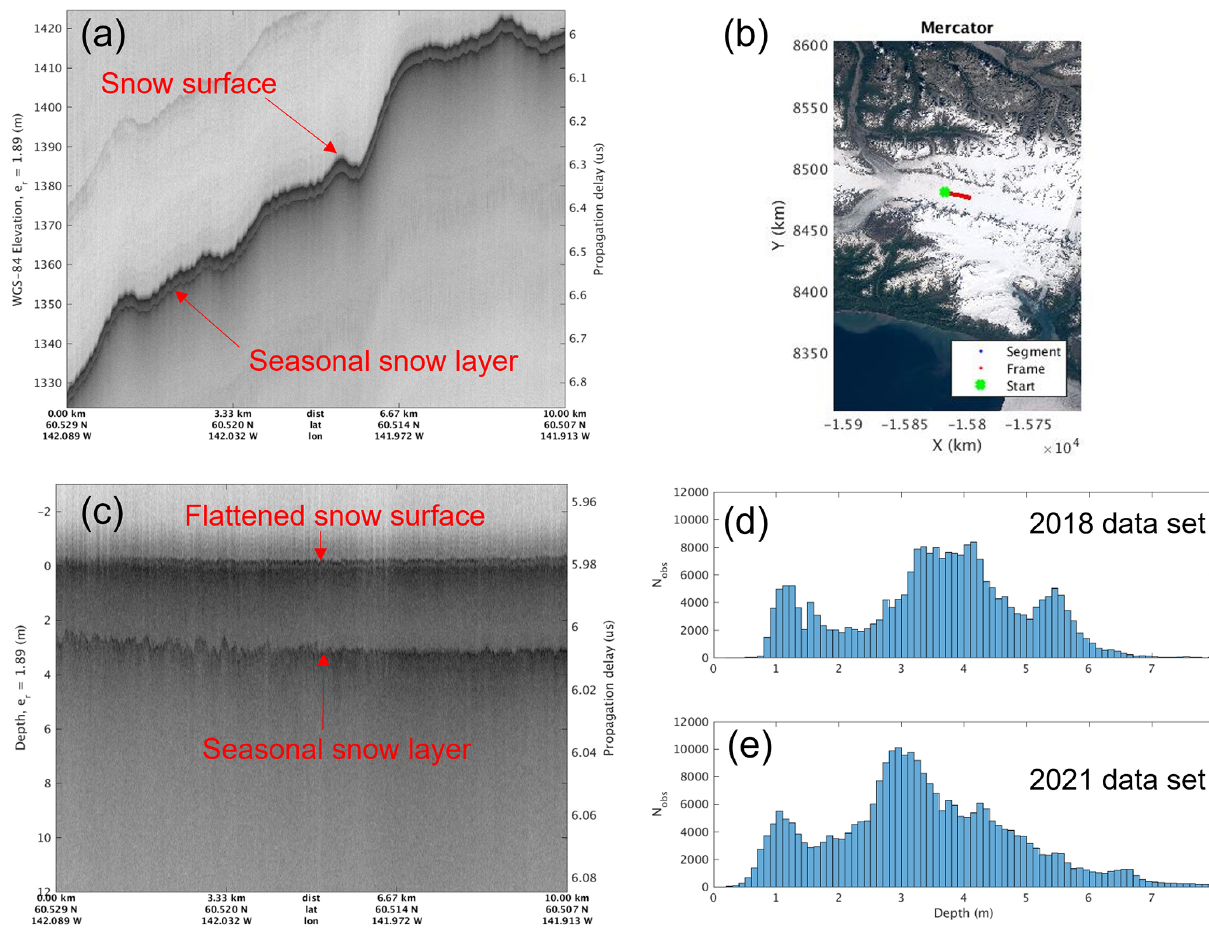
Figure 3. (a) Seasonal snow observations in Bagley Icefield (BA); (b) geolocations of the radar echogram indicated by the red line on the Landsat image map; (c) snow depth around 3m shown after the glacier surface profile is flattened; (d, e) tracked seasonal snow depth distributions of 2018 and 2021